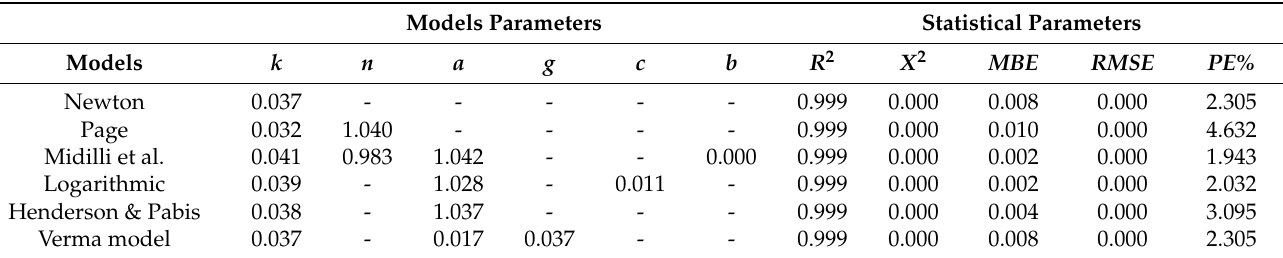
Table 3. Values of the parameters of the models for non-astringent persimmon “Rojo Brillante”. Models Parameters Statistical